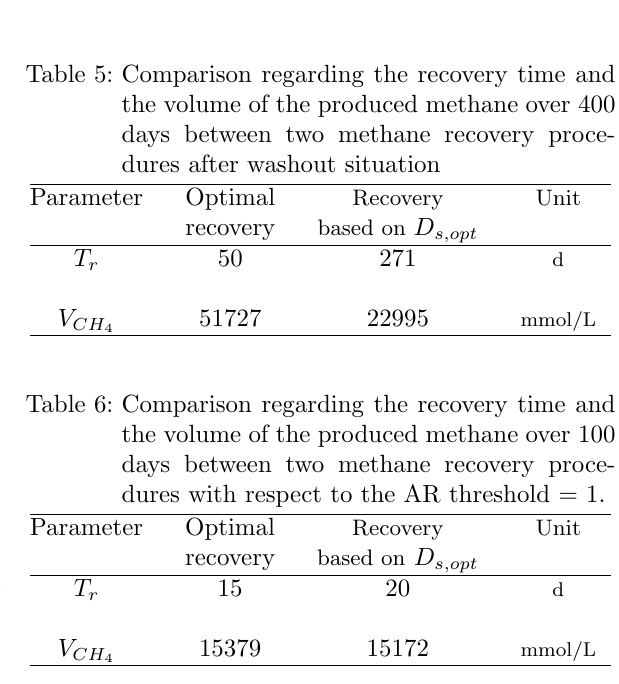
Figure 4: Optimal recovery of the methane production after a washout situation. In time axis, the blue band is a stable operating condition. The red band represents unhealthy condition and the green band is the recovery period.